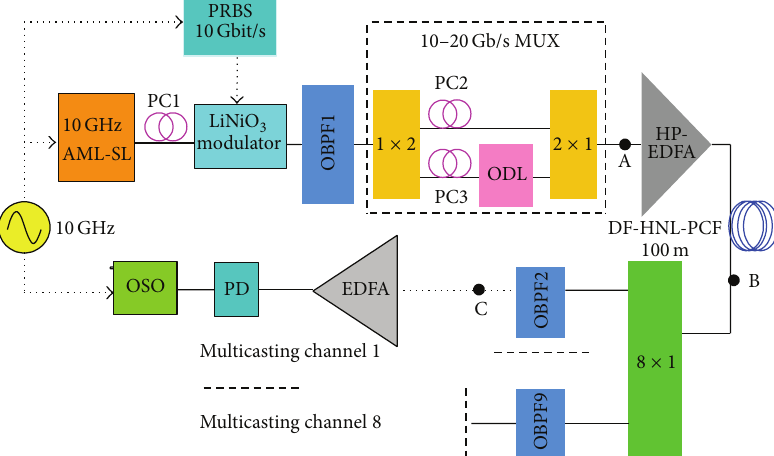
Figure 1: Experimental setup of DF-HNL-PCF based all-optical wavelength multicasting